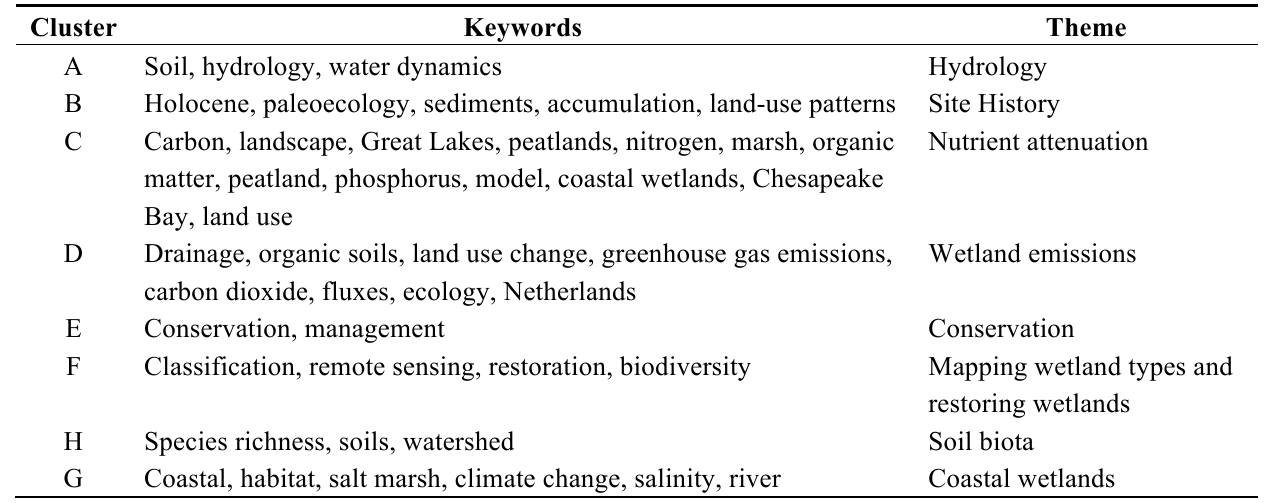
Table 2. Keyword descriptions of clusters for wetland publications containing the keywords “land use” or land cover” from 1991–2011.